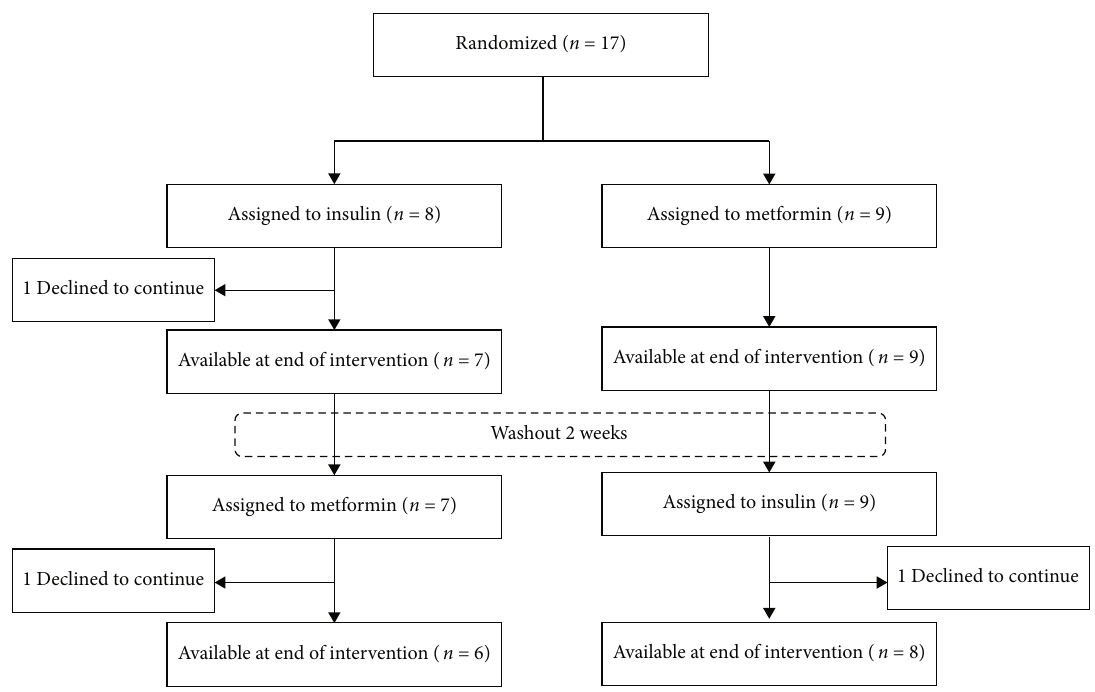
Figure 2: CONSORT (Consolidated Standards of Reporting Trials) fl ow